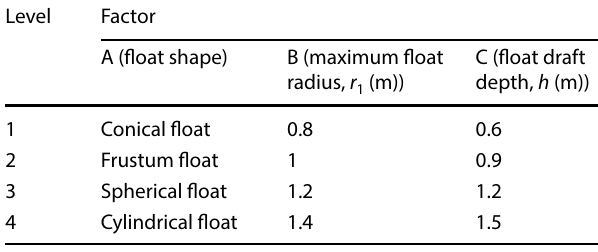
Table 1 Factors and levels of optimization